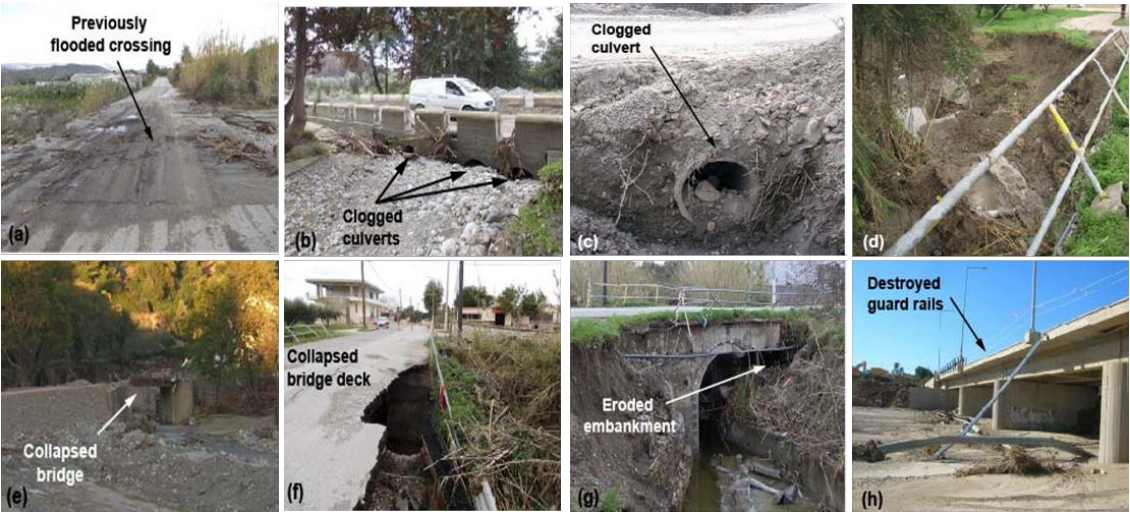
Figure 6. Types of damages on river crossing infrastructure, ranging from inundation only (a), clogging of waterways (b, c), damages on parts of a bridge (d, f, h) and complete collapse of the infrastructure (e, g) In total, it was found that a significant percentage of river crossings experienced the above types of effects and damages. The percentage of river crossings that suffered inundation or any other type of effect ranges from 54.3% to 83.3% depending on the basin (Table 3). In fact, out of 131 river crossings mapped in the five basins, 92 (or 70.2%) experienced effect types 2 to 5, whereas only 39 (29.8%) of them were not affected at